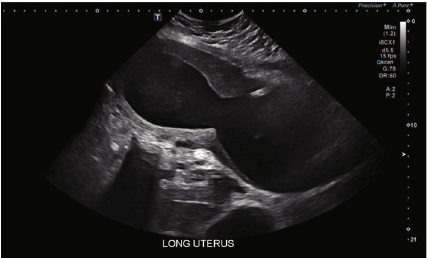
Figure 1: Transabdominal sagittal view of the uterus and vagina. The vagina, cervix, and uterus are distended with heterogeneous fl uid.